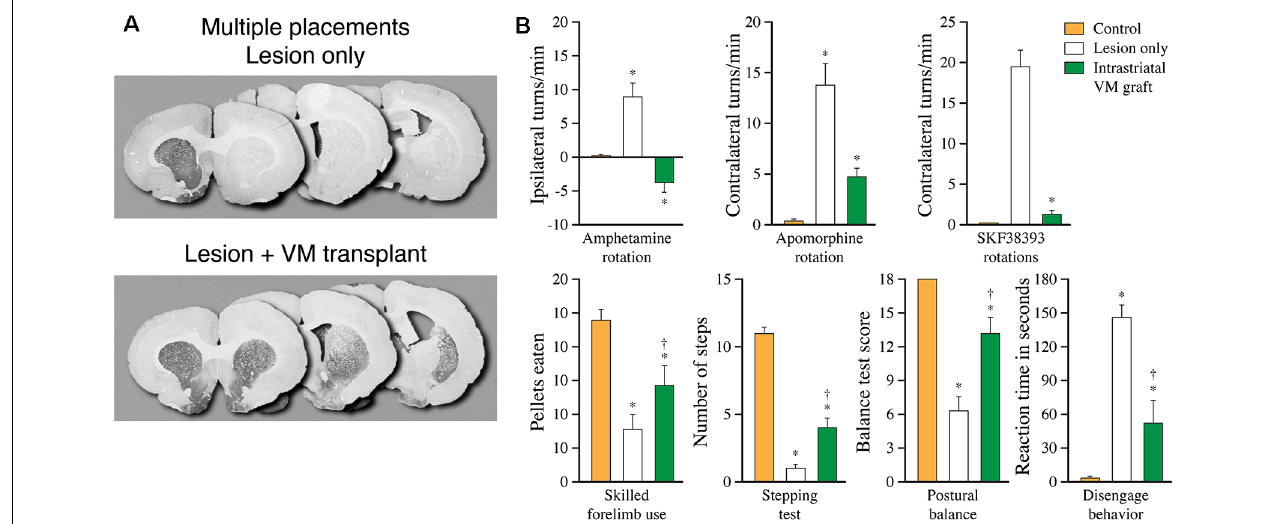
FIGURE 6 | More complete recovery can be obtained by spreading the graft tissue over multiple implantation sites. (A) Extent of graft induced reinnervation obtained with fetal VM grafts spread over seven injection sites distributed over the entire striatum, including the nc. accumbens, 10 months post-grafting. (B) In these animals, significant functional recovery is seen in a broad range of drug-induced and spontaneous motor tests, but remains incomplete in most of the tests Data compiled from Winkler et al. (1999). ∗ Different from Control at p < 0.05; † different from Lesion only at p <